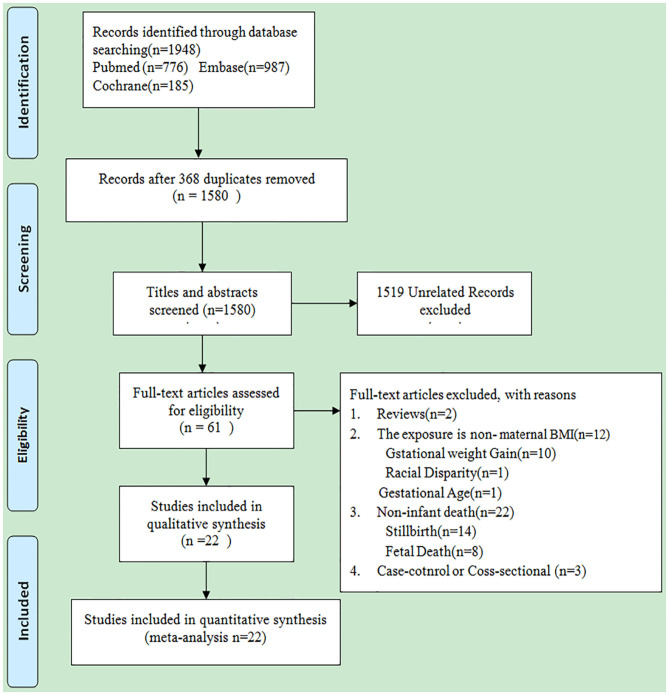
Flow chart of the study retrieval process.